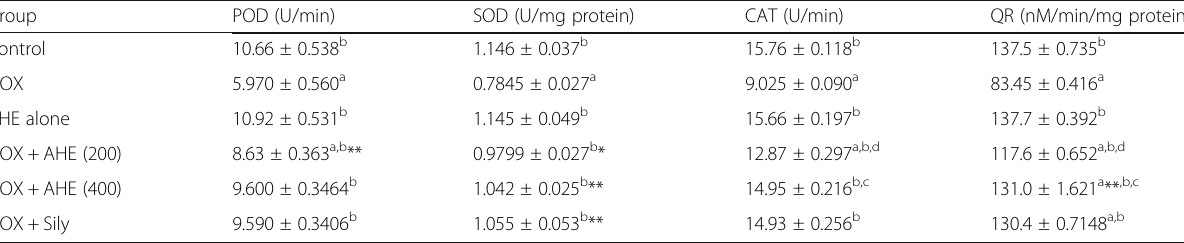
Table 4 Effect of Doxorubicin (DOX) and AHE treatment on cardiac tissue antioxidant enzymes Group